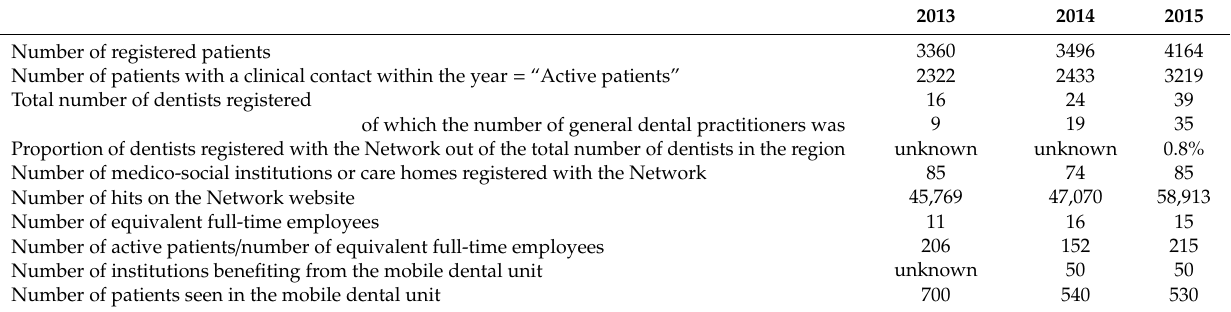
Table 2. Overview of the R é seau Sant é Bucco-Dentaire et Handicap de la r é gion Rh ô ne-Alpes (RSBDH) in